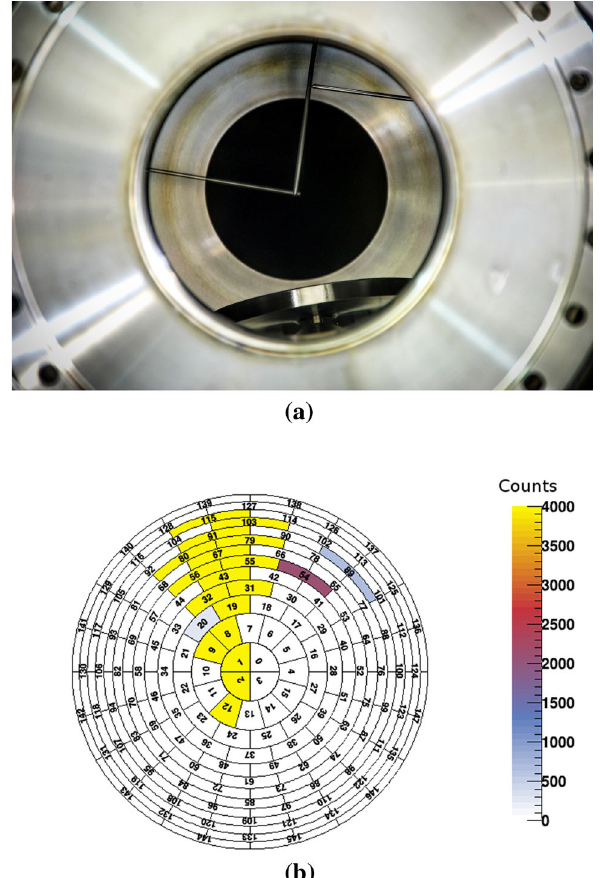
trometers (looking down the beamline). The left and central catchers are inserted into the flux tube, while the right catcher is retracted. b FPD pixels affected by the shadow from the central electron catcher (the position of the shadow is mirrored to the image of the catcher on a becauseoftheoppositedirectionofview).Thetotalelectroncountfrom a photoelectron source was measured with the catcher inserted into the flux tube, and this count was then subtracted from the count obtained with all three catchers retracted for the same amount of time (10 min); therefore, higher counts are observed for the shadowed